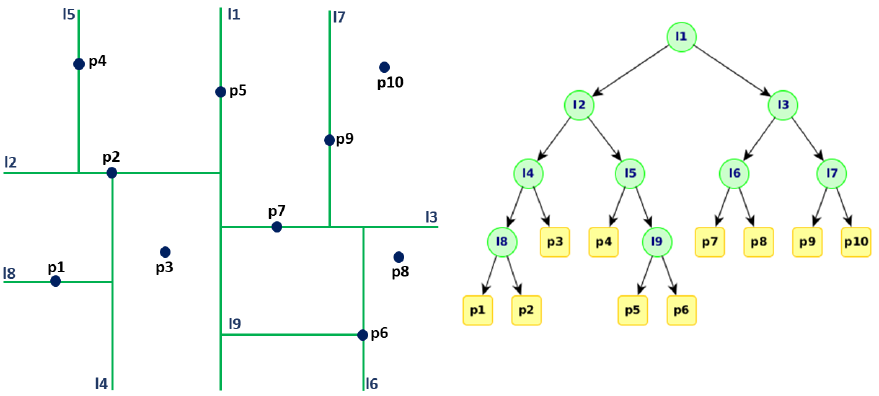
Figure 4. Visualization of the k-d tree